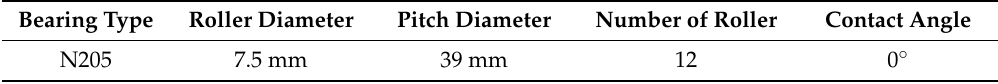
Table 4. The parameters of cylindrical bearing.